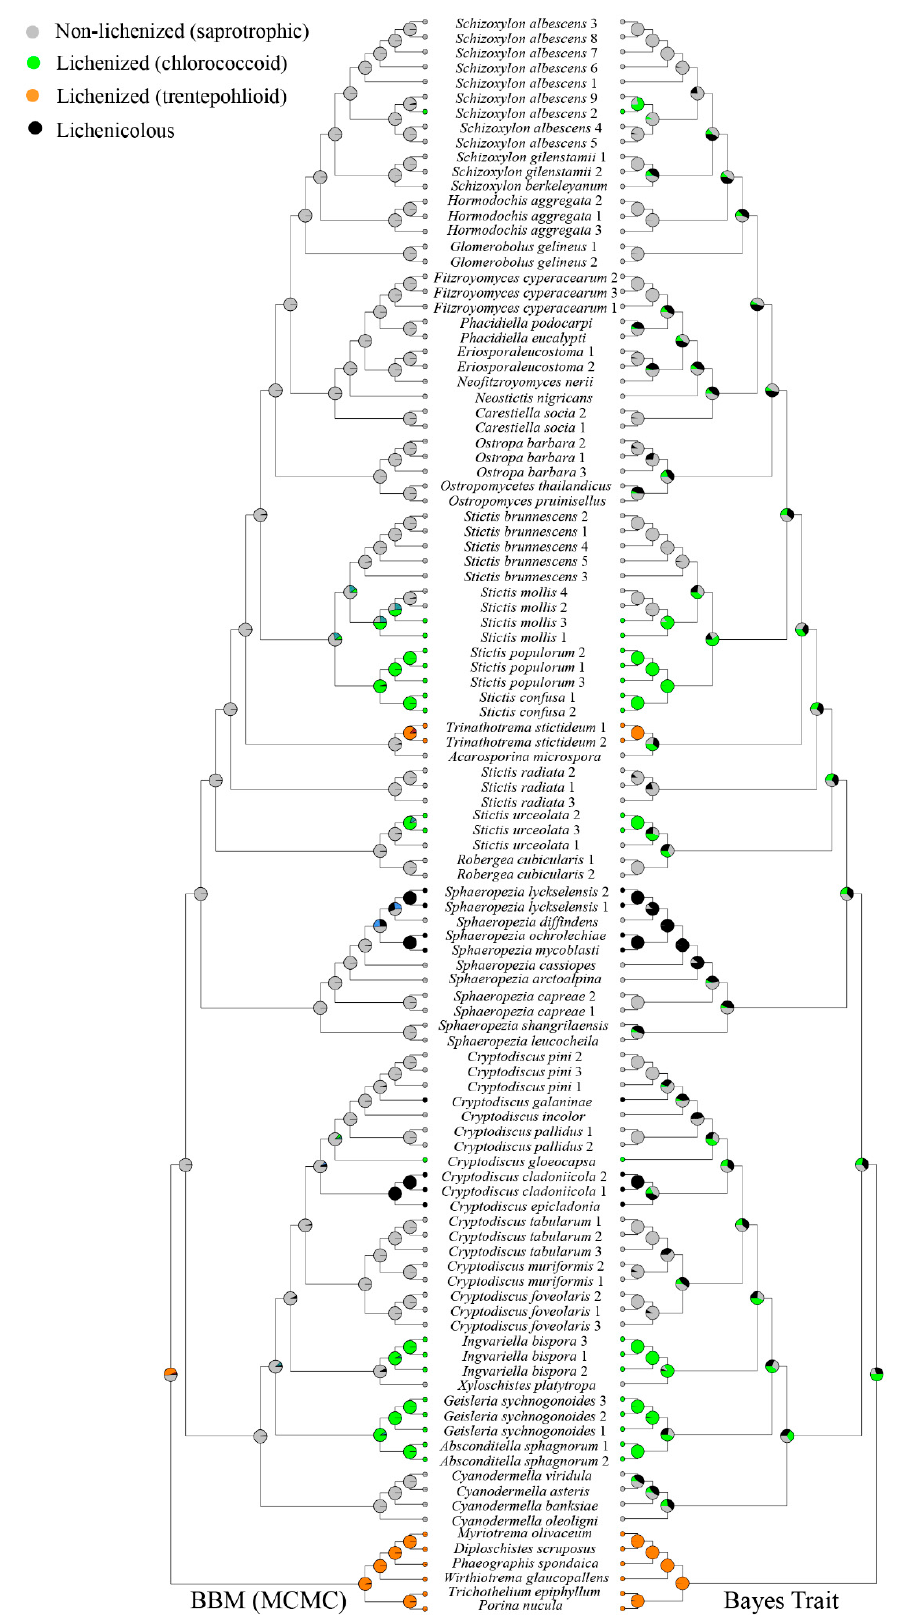
Figure 3. Ancestral character state analysis of Stictidaceae using Bayesian Binary MCMC and Bayes Traits. Color symbols indicate: green = chlorococcoid, orange = trentepohlioid, gray = non-lichenized saprotrophic, black = lichenicolous.